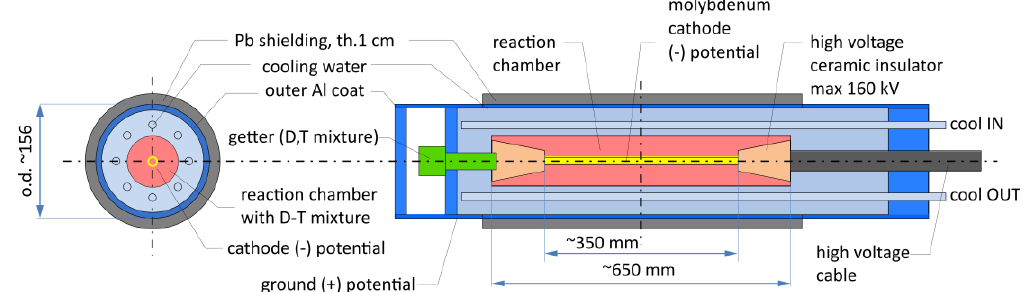
Figure 2. Diagram of the NSD-350-24-DT-C-W-S “sealed